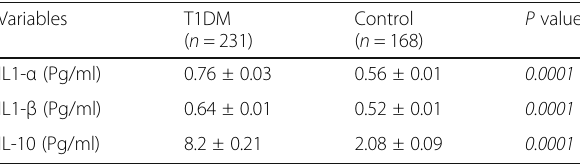
Table 2 Serum levels of inflammatory cytokines in T1DM and control groups